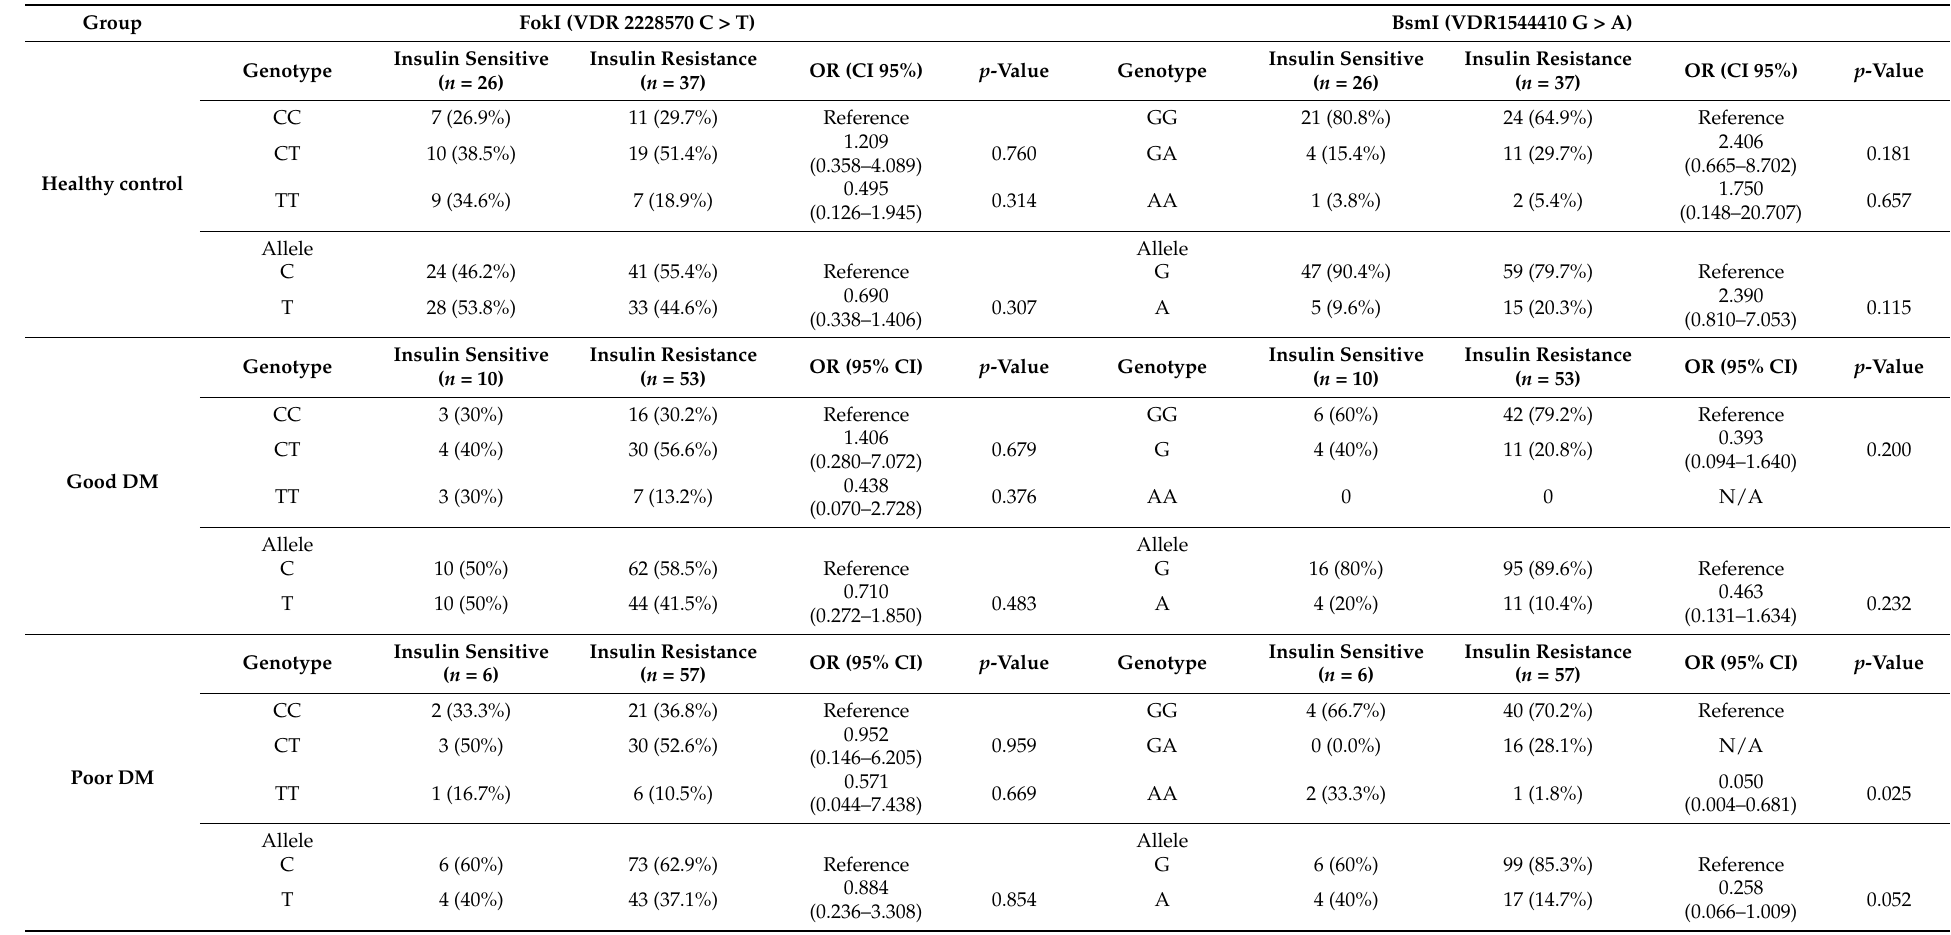
Table 4. Association between VDR polymorphism at FokI (VDR 2228570 C > T) and BsmI (VDR1544410 G > A) and risk of insulin